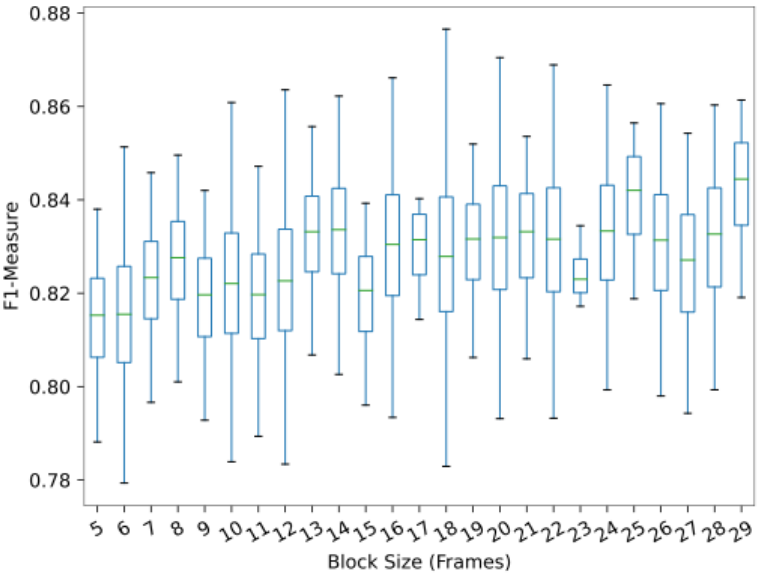
Figure 9. Performance of block sizes (5–29 frames) as input of the LRCN for the Electrobyte